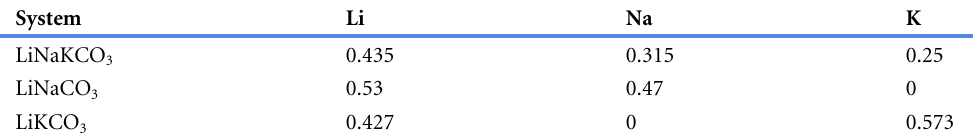
Table 1 Cation fractions for the eutectic salts used in this